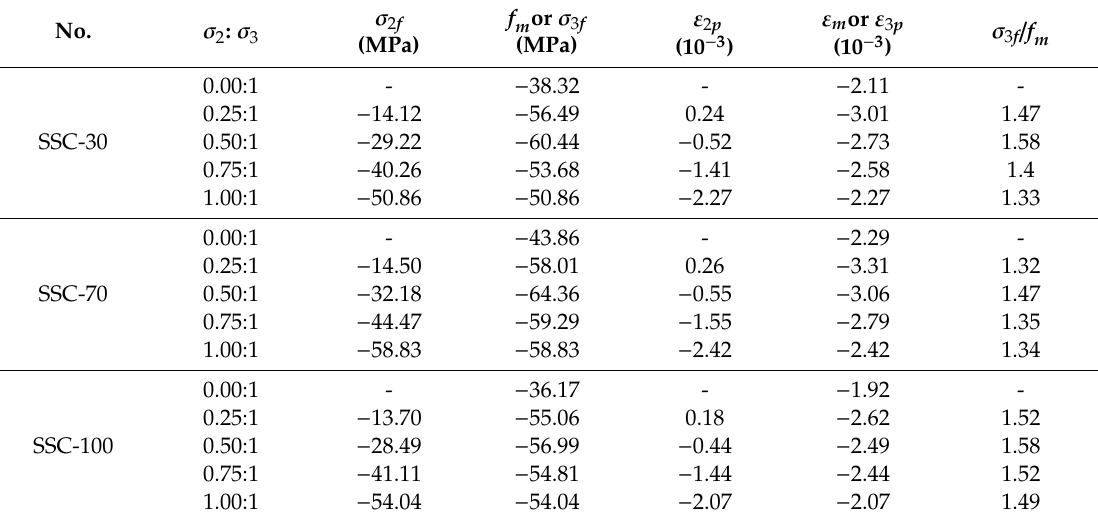
Table 3. Test value of SSC under uniaxial and biaxial